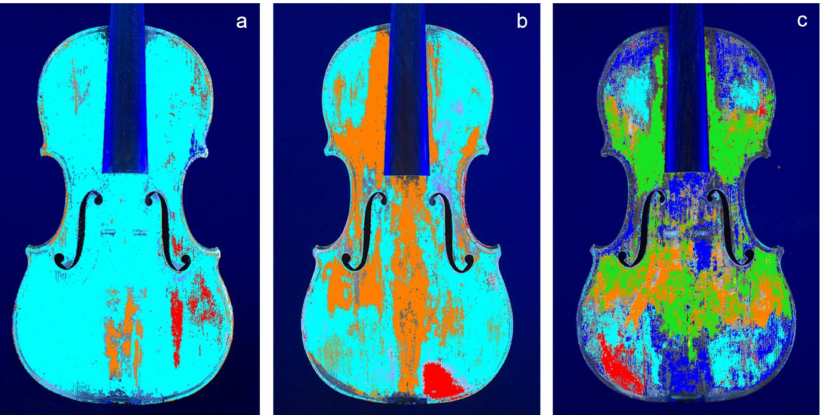
Figure 2. Images of the soundboard of ( a ) the “Spagnoletti”, ( b ) the “Stauffer”, and ( c ) the “Principe Doria” violins obtained through UV Analyzer. Different colors correspond to best-conserved (orange), worn-out (light blue), and restored (red, blue, and green) areas, according to their different UV- induced fluorescence colors. Areas identified on the back plates are shown in Figure S2 in the Supplementary